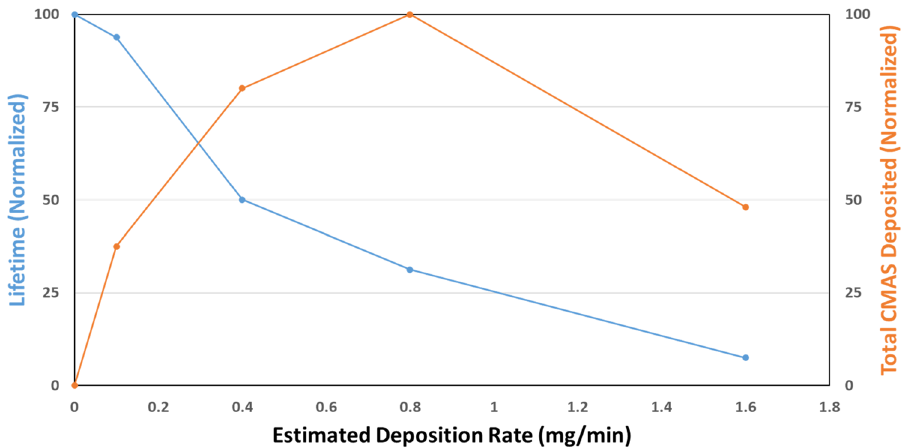
Fig. 2 Summarized results of CMAS deposition rate effects on TBC lifetime. Solid blue lines indicate experimental results. Cycling data is normal- ized against the lifetime of a TBC subjected to the same thermal profile without